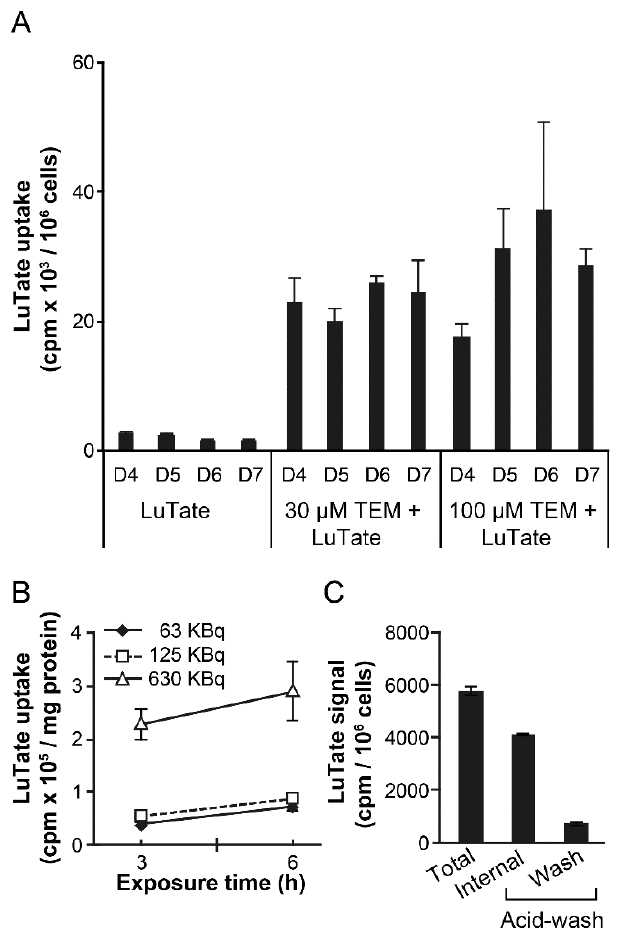
Figure 3. TEM-induced increase in uptake of LuTate by BON-1 cells. ( A ) LuTate uptake by TEM- treated BON-1 cells. BON-1 cells treated for 24 h with 30 or 100 µ M TEM (or mock) and allowed to recover in fresh medium for 7 more days. The cells were exposed for 3h to LuTate on days 4–7 after TEM treatment, and harvested for measuring LuTate uptake and viable cell count. Data derived from triplicate samples of four independent experiments is represented as mean ± SE ( B ) Dose and time-dependent uptake of LuTate by BON-1 cells. The BON-1 cells were incubated for 3 or 6 h with specified doses of LuTate and assessed for total cellular uptake of radiolabel. ( C ) Distribution of total LuTate uptake as internalized in the cell versus plasma membrane-bound activity. BON-1 cells treated for 3 h with 125 KBq LuTate were processed for measuring total, internalized (acid wash resistant) and membrane bound (acid-wash removable) LuTate. For panels B and C, the data derived from two experiments, each with triplicate dishes are represented as Mean ± SE ( n =